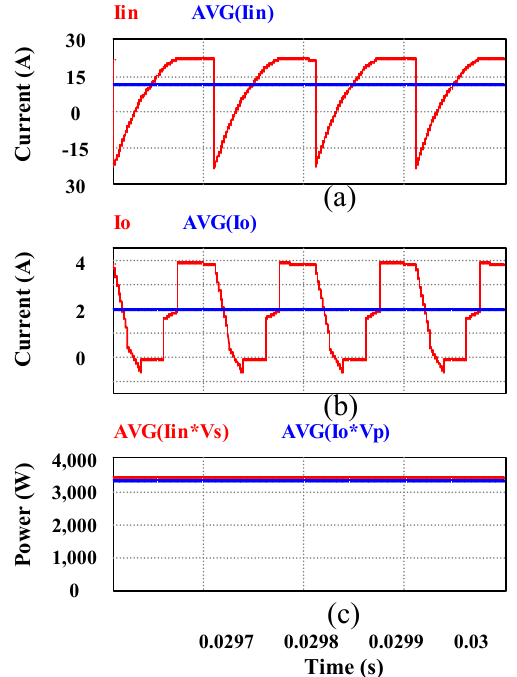
Figure 19. (From top to bottom) ( a ) ML-DAB input current (cid:1835) current (cid:1835) and its average; and ( c ) average input and output power (cid:3042)(cid:3048)(cid:3047) ) and (cid:1842) = (cid:1827)(cid:1848)(cid:1833)((cid:1835) ∗ (cid:1848) = (cid:1827)(cid:1848)(cid:1833)((cid:1835) ∗ (cid:1848) ) . (cid:1842) (cid:3036)(cid:3041) (cid:3036)(cid:3041) (cid:3046) (cid:3042)(cid:3048)(cid:3047) (cid:3042) (cid:3017)